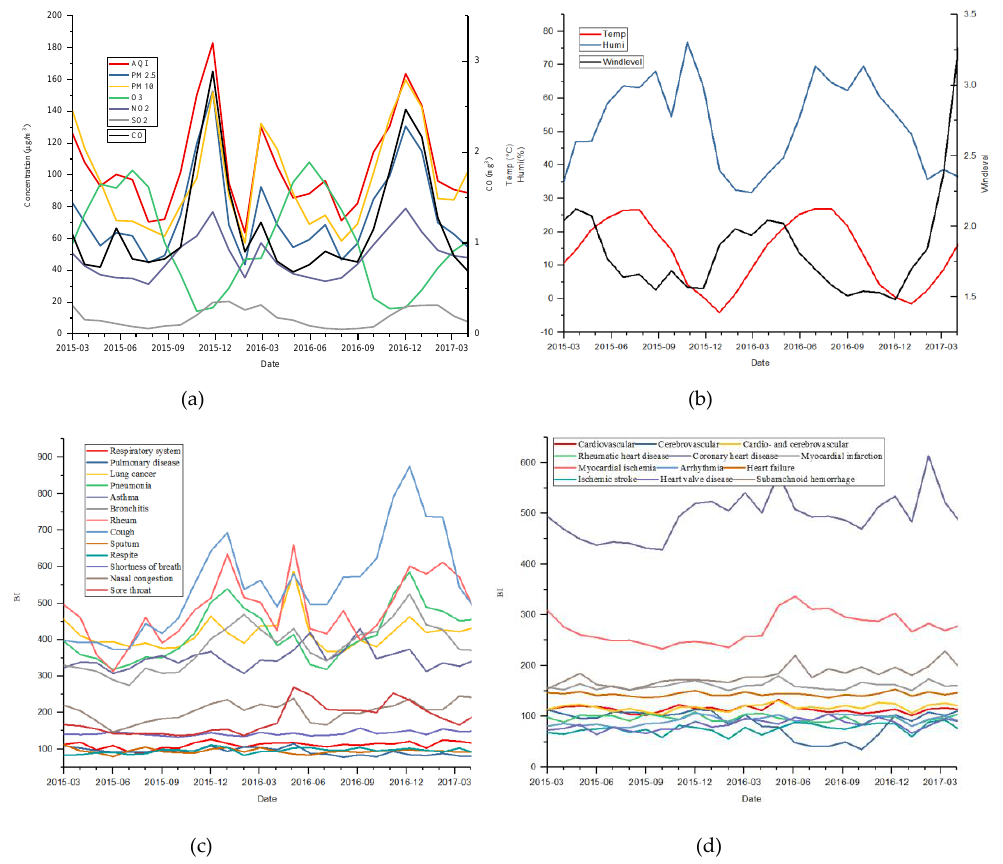
Figure 5. ( a ) AQI and six major air pollutants, where CO is shown on the right side of the vertical axis; ( b ) meteorological factors, where wind level is shown on the right side of the vertical axis; ( c )